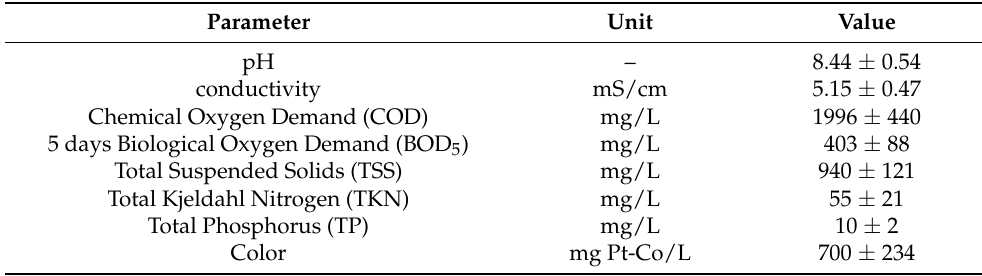
Table 1. Characteristics of the